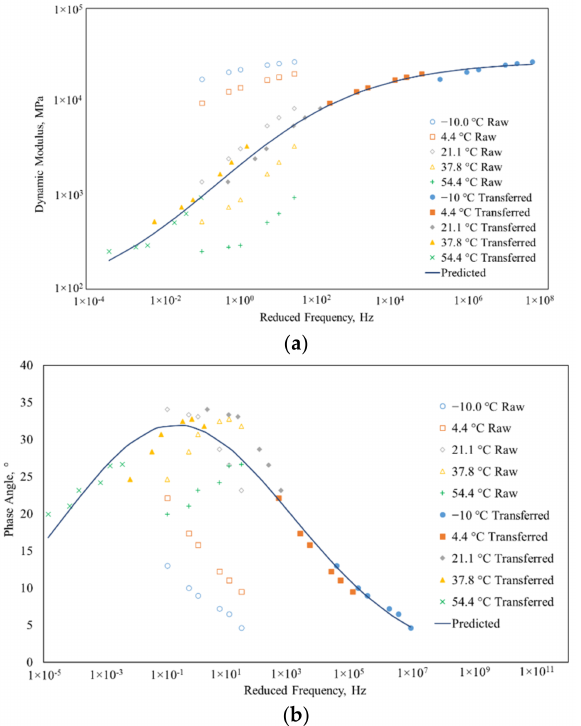
Figure 7. Test results and master curve model predictions: ( a ) dynamic modulus at 18.8 ◦ C; ( b ) phase angle at 23.1 ◦ C. Table 6. Master curve model parameters of dynamic modulus and phase